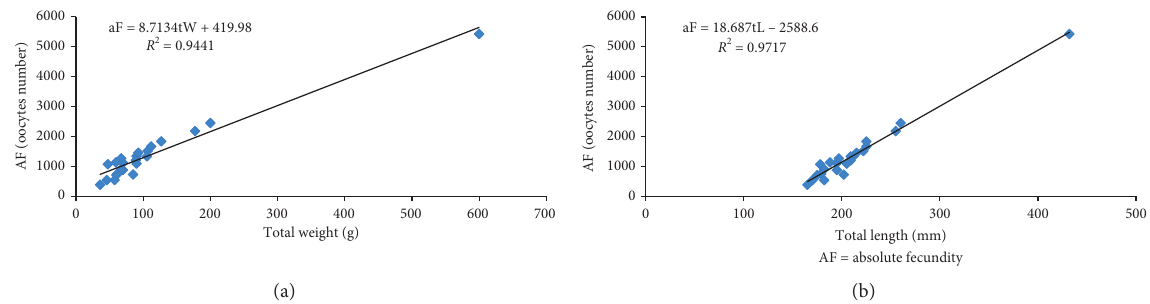
Figure 8: Relationship between absolute fecundity and total weight (a) and the total length (b) in C. nigrodigitatus females in the Nkam